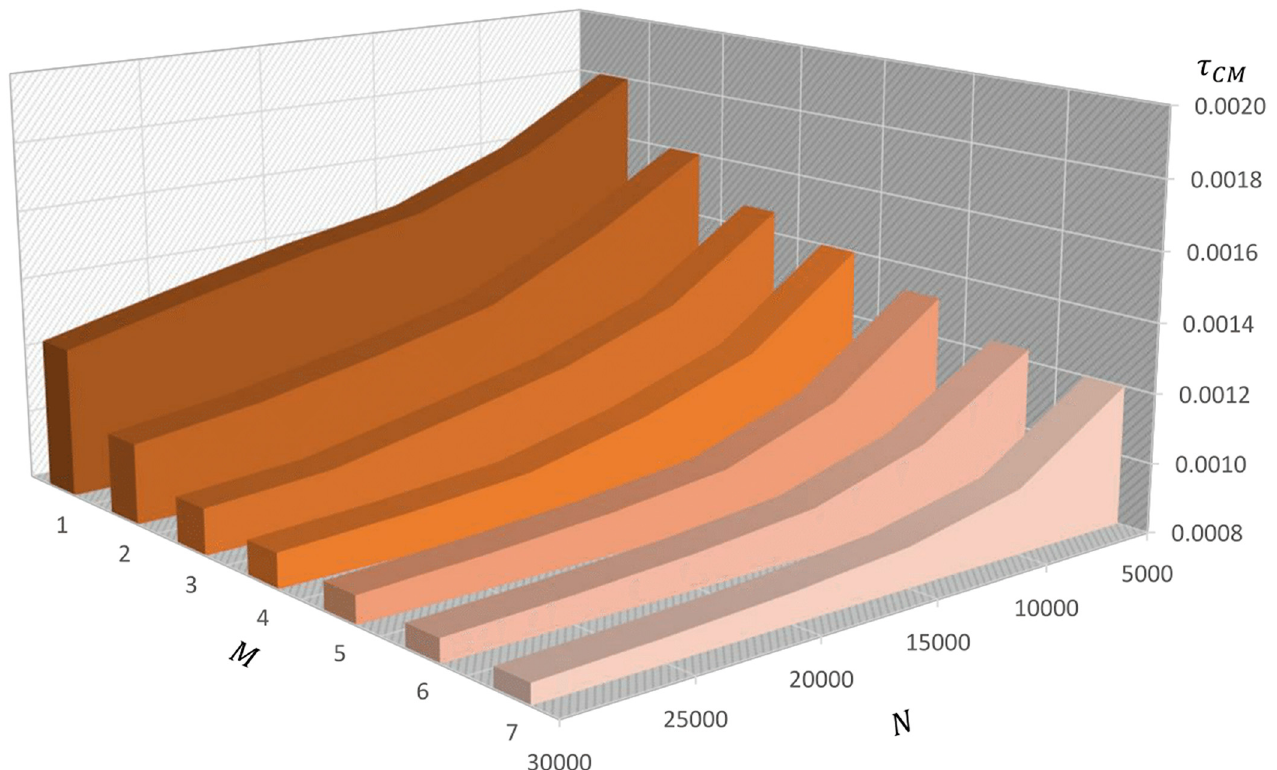
Fig 3. Critical mass density. The Critical Mass Density as a function of the population ’ s size N and the number of layers M